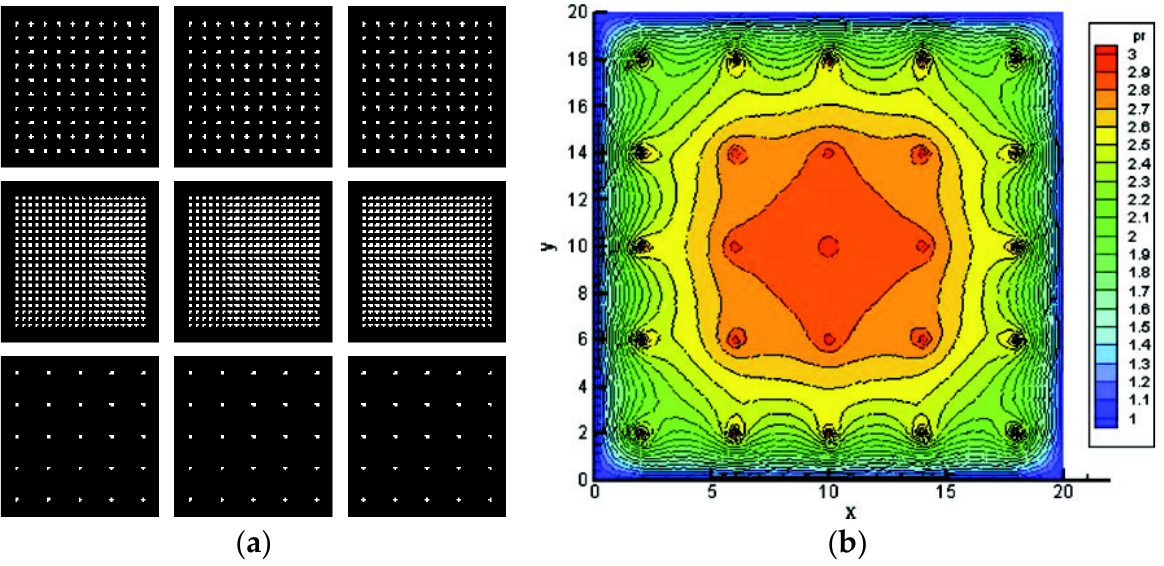
Figure 9. Aerostat thrust bearings with micro holes [33]: ( a ) configuration of ATBs with micro holes, ( b ) the pressure simulation results.